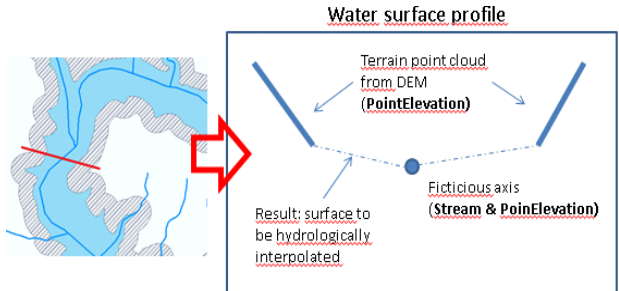
Figure 7. Hydrological modelling of water surface. Top image: an area of a water surface from a reservoir, bottom image shows the indicated profile where both sides (PointElevation from DTM) comes from an outside buffer made over the water surface (grey zone at top image) DEM buildings